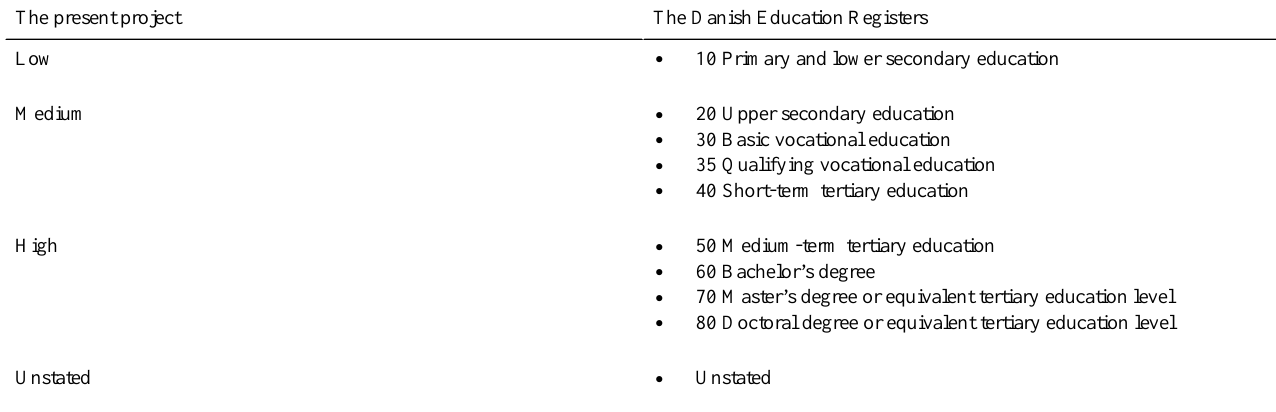
Table 2. Classification of education